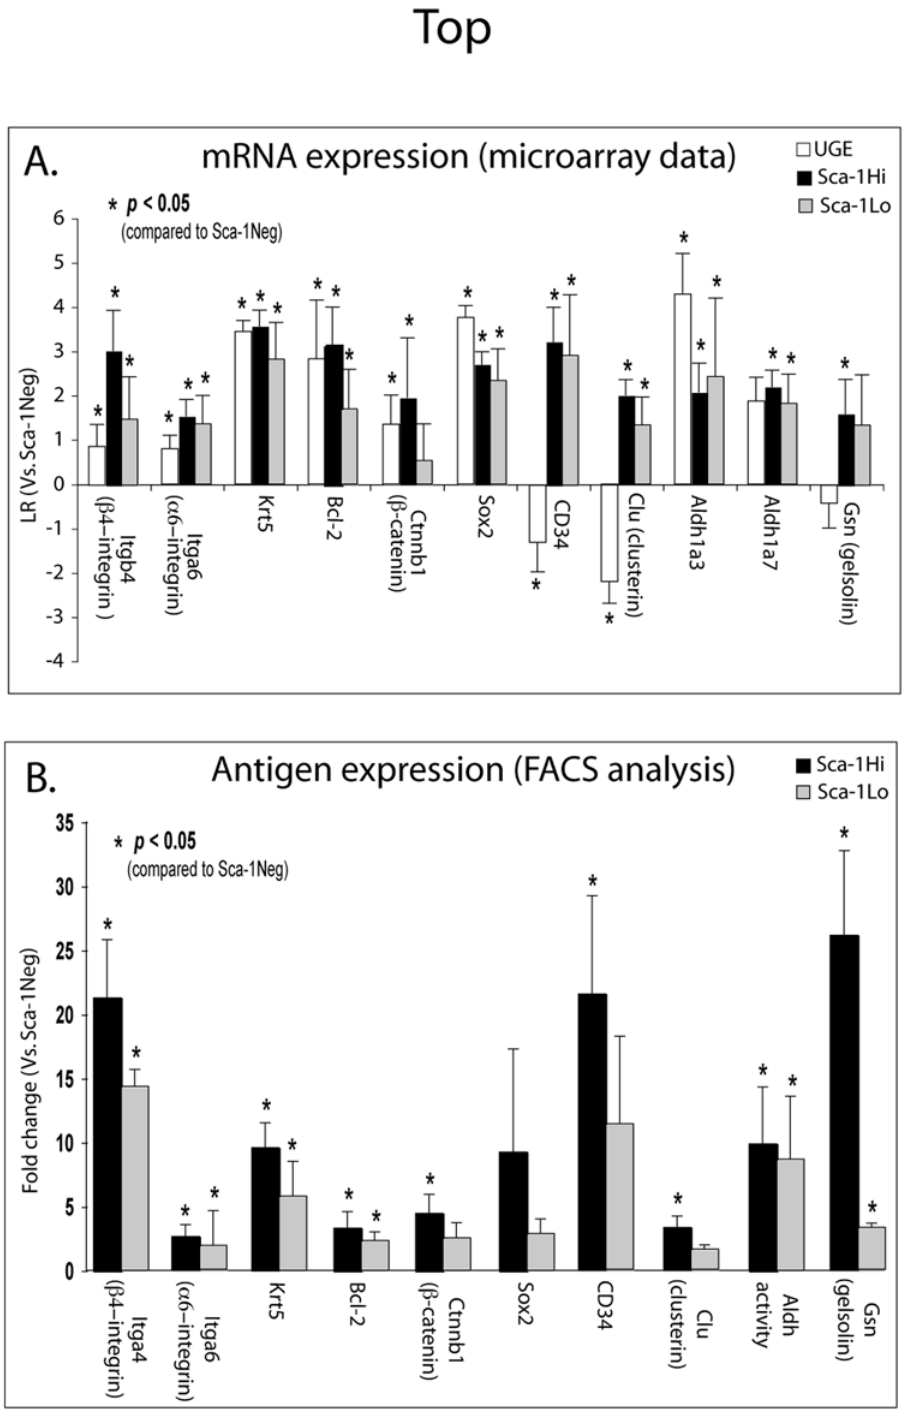
Figure 3. Transcript and protein expression of SC markers in primitive (UGE, Sca-1 Hi ) and progenitor (Sca-1 Lo ) cells. A. Transcription level of SC markers in primitive and progenitor prostate cells. Microarray data of SC markers from these primitive cell populations are expressed as LR values [mean 6 SD] relative to mature Sca-1 Neg samples. B. Antigen expression of SC markers on Sca-1 Hi and Sca-1 Lo cells. FACS analysis of Sca-1 Hi and Sca-1 Lo cells determined the expression of SC markers (denoted in A) on these populations. Enrichment values [mean 6 SD] are expressed as the fold change in antigen expression relative to the antigen expression of the mature Sca-1 Neg cell population.